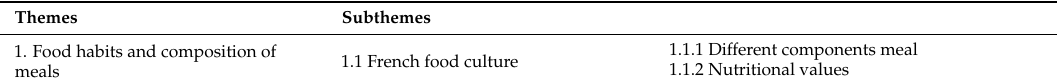
Table 2. Themes and subthemes resulting from the